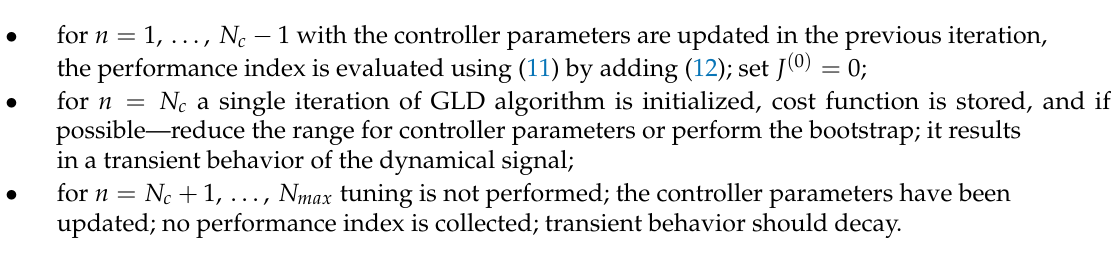
Algorithm 3 Evaluation of performance index (with single change of controller parameter) [26] Recalling defined N c , N max , and n for f ( · ) .